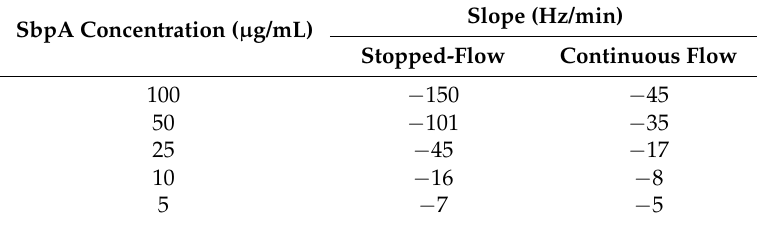
Table 1. Frequency vs. time slope value variation for different concentrations of SbpA and injection methods.